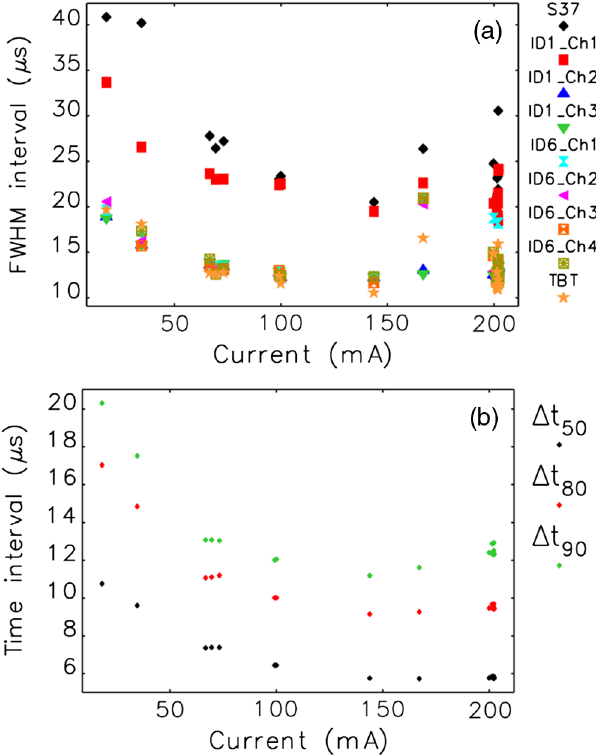
FIG. 35. Contour plots from the ID1 external FO bundle BLM during the 18 mA beam dump. The fill pattern held 27 equally spaced 2.2 nC bunches. The horizontal (fast) axis shows loss signals within a turn, and the vertical (slow) axis shows behavior turn by turn. Part (a) shows loss signals over a full turn on the fast axis; (b) zooms in on losses from three adjacent